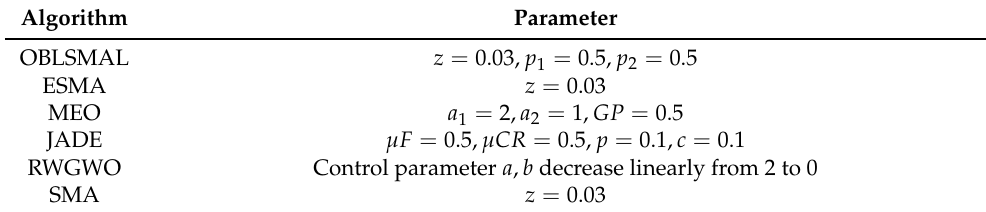
The DQOBLSMA has been compared to the original SMA and five other algorithms: the slime mold algorithm improved by opposition-based learning and Levy flight distribu- tion (OBLSMAL) [48], the equilibrium slime mold algorithm (ESMA) [49], the equilibrium optimizer with a mutation strategy (MEO) [50], the adaptive differential evolution with an optional external archive (JADE) [51], and the gray wolf optimizer based on random walk (RWGWO) [52]. The parameter settings of each algorithm are shown in Table 3, and the experimental parameters for all optimization algorithms were chosen to be the same as those reported in the original works. Table 3. Parameter settings for the comparative algorithms.